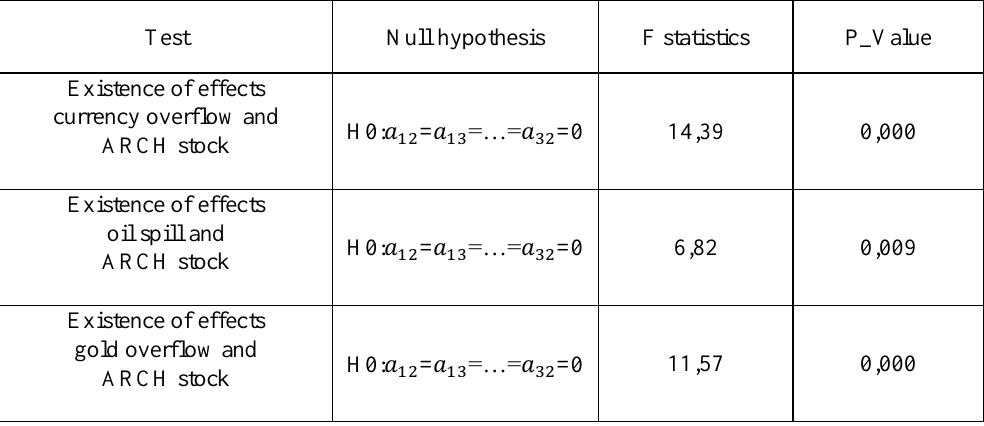
Table 1. F test results to investigate the effects of turbulence